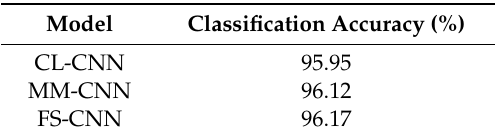
Table 3. Type and sample number of training and testing set.